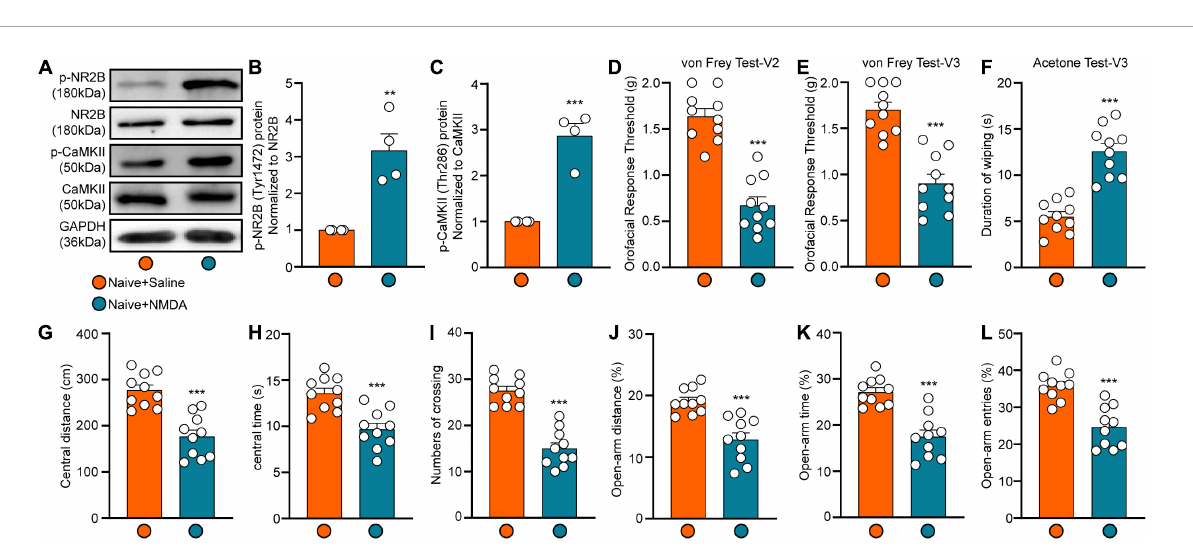
FIGURE5 The expression of p-NR2B and p-CaMKII and behavior results after LHb injection of NMDA. The p-NR2B and p-CaMKII protein expression of the Hb at 4 h after NMDA injection was shown by the representative blots (A) . The quantitative results were shown by the histograms (B,C) , N = 4 mice per group. The mechanical and cold allodynia in both V2 and V3 areas appeared at 2 h after LHb NMDA administration (D–F) . The central distance (G) , central time (H) , numbers of crossing (I) in the OFT and the percentage of open-arm distance (J) , open-arm time (K) , and open-arm entries (L) in EPM test were significantly decreased at 2 h after LHb injection of NMDA. N = 10 mice per group, ** p < 0.01 and *** p < 0.001 compared with the Naive+Saline group.